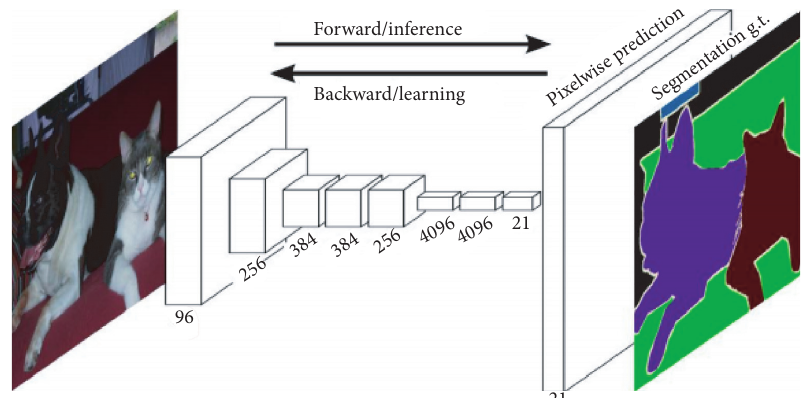
Figure 2: Illustration of fully convolutional networks for semantic segmentation